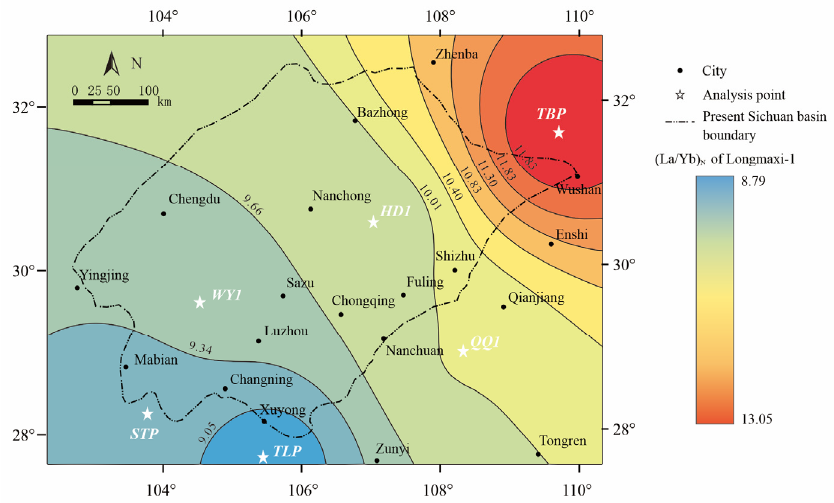
Figure 10. The distribution of (La/Yb) N of the Upper Yangtze region (southern China) during the sedimentary period of Longmaxi-1 in Early Silurian.